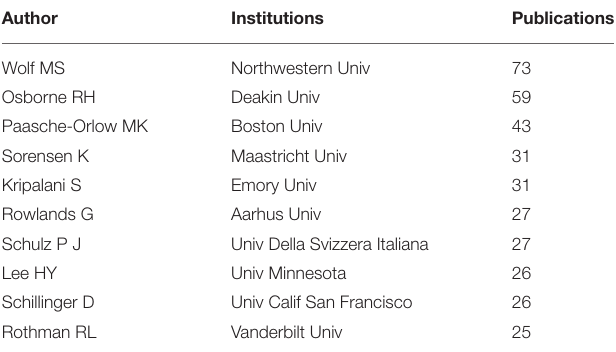
TABLE 4 | The top 3 contributors in the field of health literacy